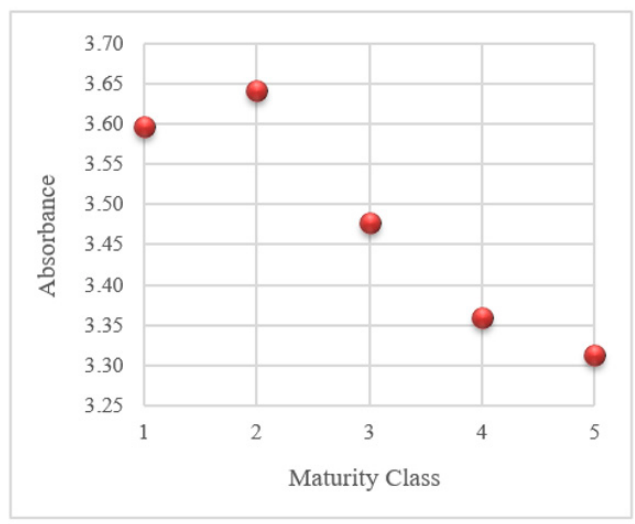
Figure 5. UV absorbance at 260 nm of the steeping solutions of seeds of the five maturity classes (20 ml water/g seed).